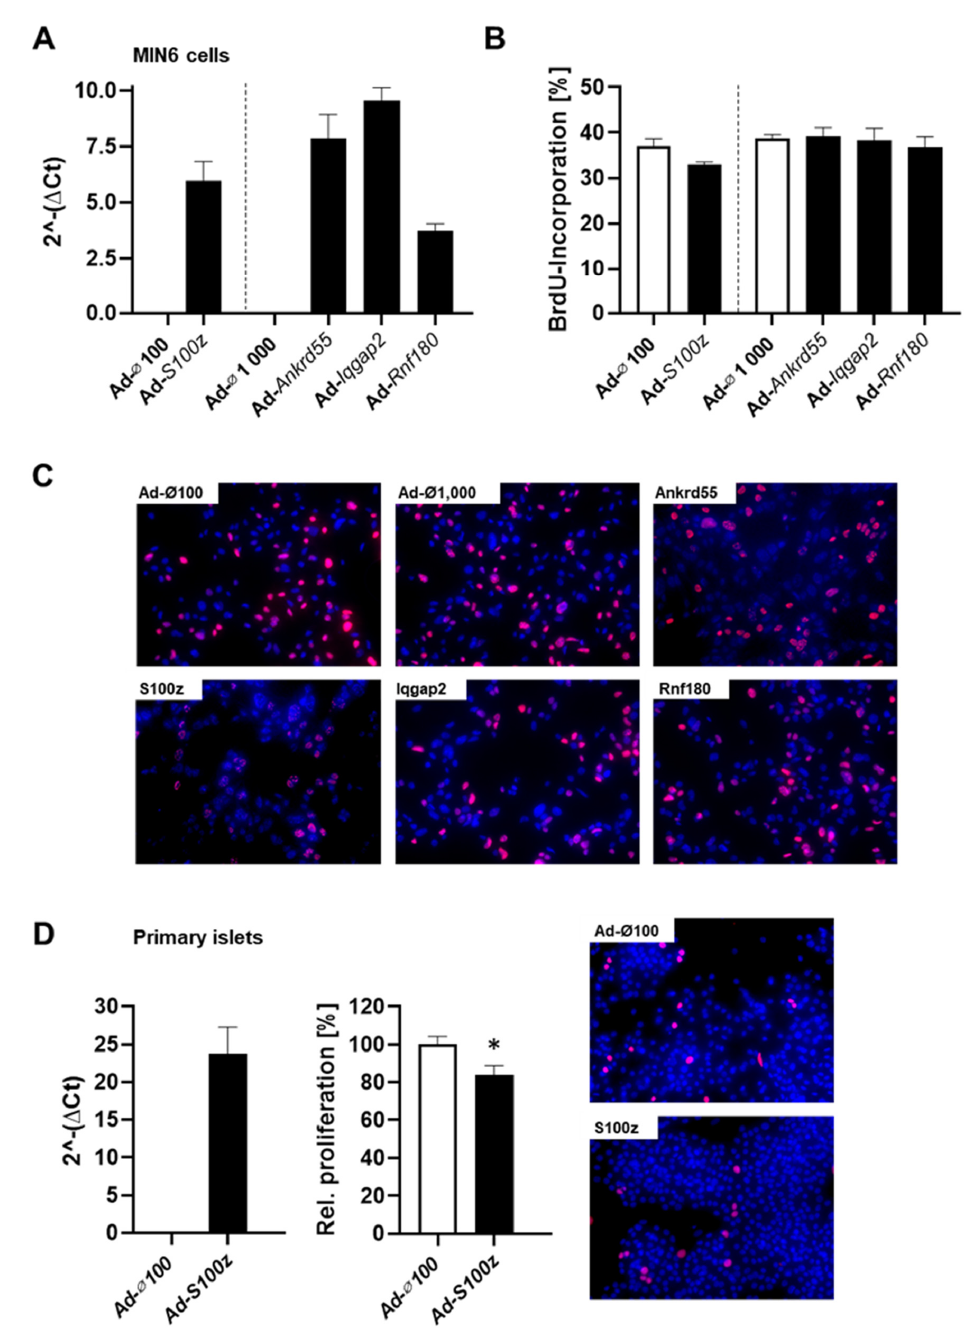
Figure 4. Impact of the different Nidd13/NZO candidate genes on proliferation. ( A ) MIN6 were infected with an empty adenovirus (Ad- ∅ ) as control or an adenovirus expressing one of the Nidd13/NZO candidate genes; overexpression was analyzed by qRT-PCR. ( B ) Infected MIN6 cells were incubated with BrdU for 72 h. For quantification, cells were counted and assessed as BrdU positive or negative. For each group, 10 pictures of at least two coverslips per infection ( n = 4) were evaluated. ( C ) Representative immunocytochemical co-stainings of BrdU (magenta) and DAPI (blue). ( D ) Primary islets of NZO mice were dispersed and infected with an empty adenovirus (Ad- ∅ ) as control or an adenovirus expressing S100z, and overexpression was analyzed by qRT-PCR. After incubation with BrdU for 48 h, islets were co-stained with a BrdU (magenta) and DAPI (blue) antibody. For each group, at least 10 images of four or two coverslips per infection ( n = 2) were evaluated. * p <